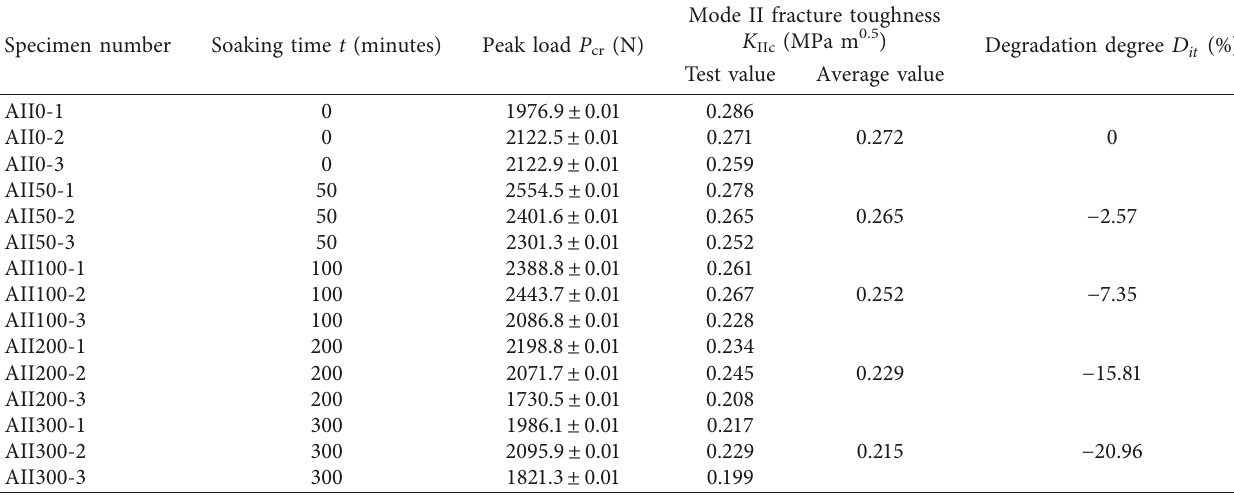
Table 5: Mode II fracture toughness of Type A mudstone specimens for different soaking times.